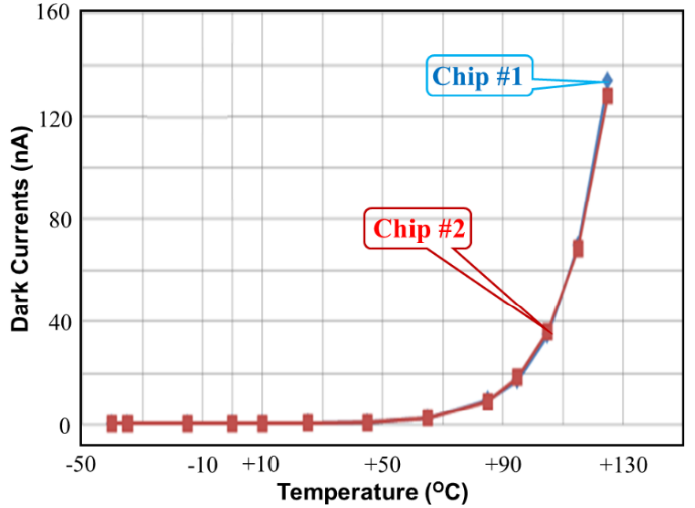
Figure 15. Measured dark currents versus temperatures for the proposed CAs with enhanced dark current cancellation.